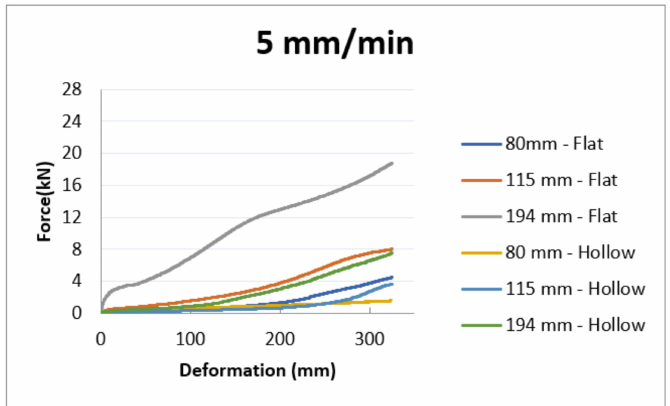
Figure 13. Deformation and force at each position for a speed of 5 mm/min.